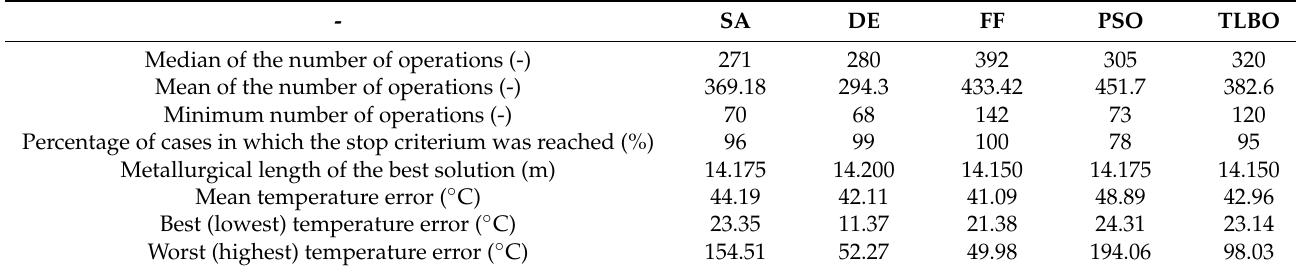
Figure 8. The water flow rates through the secondary cooling zone of the best solutions of individual algorithms. Table 4. Overall results for the considered continuous casting (CC) optimization